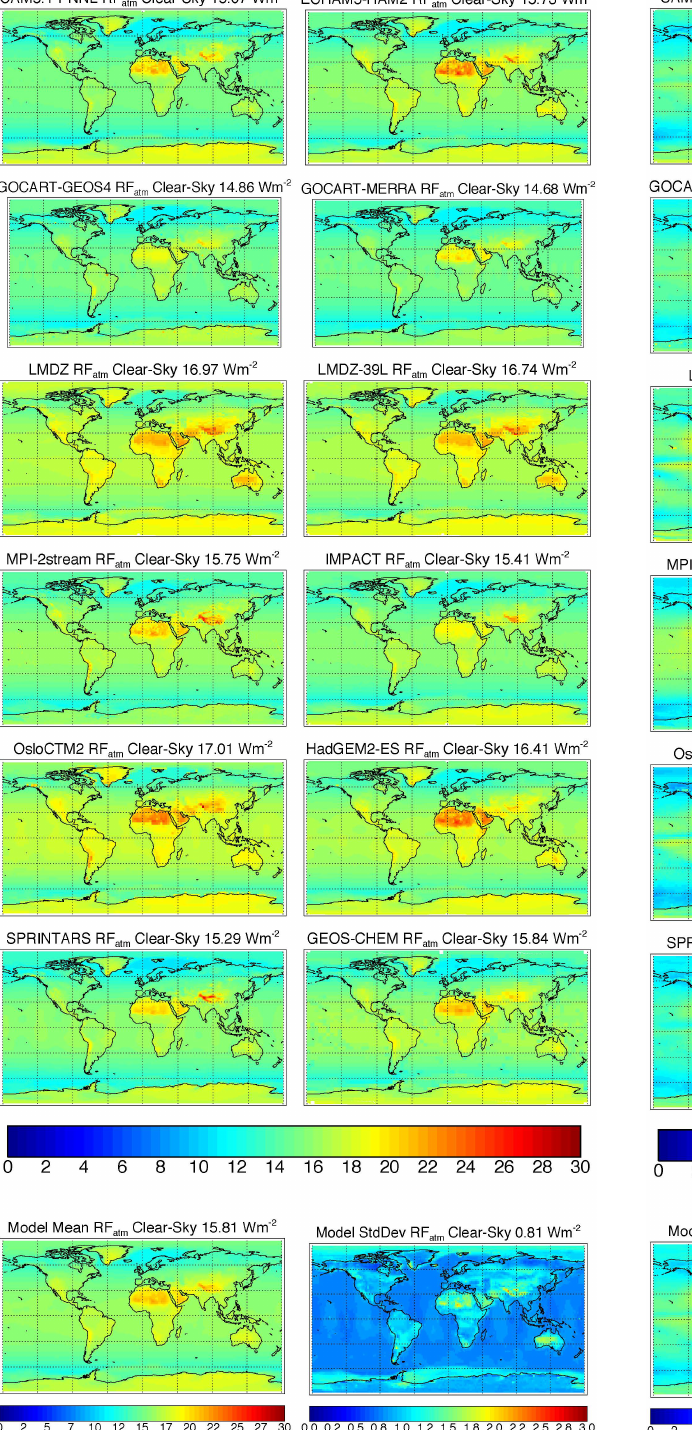
Fig. 14. Annual mean short-wave clear-sky atmospheric radia- tive forcing (absorption) between experiments with SSA=0.8 and SSA=1.0 with holding ANG=1.0 constant (FIX3-FIX2).